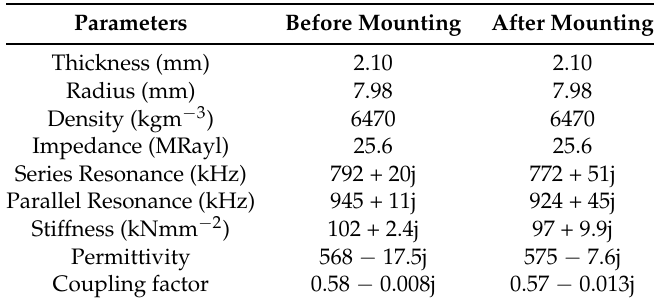
Table 1. The 1–3 composite transducer extracted